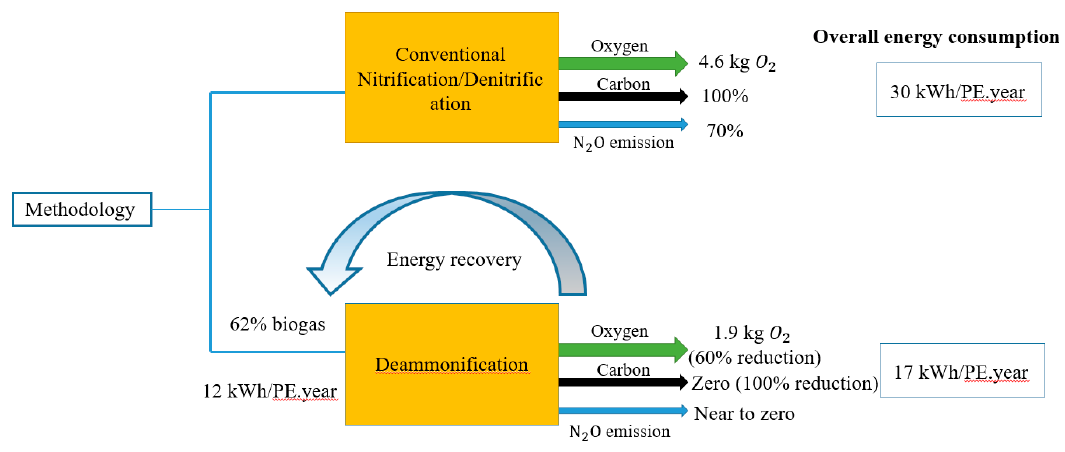
Figure 7. Energy consumption in wastewater treatment plants (WWTPs) under conventional and novel nitrogen removal methods, based on [63].